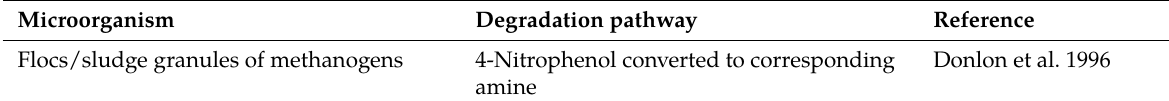
Table 5: Anaerobic biodegradation of p